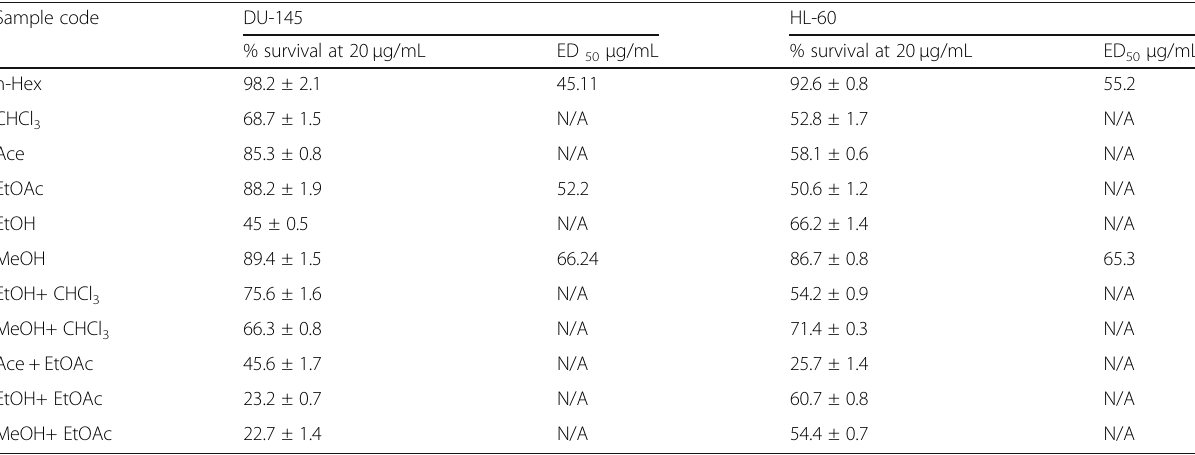
Table 4 Cytotoxic potential of A. jacquemontii extracts against DU-145 prostate cancer, HL-60 human leukemia cell lines Sample